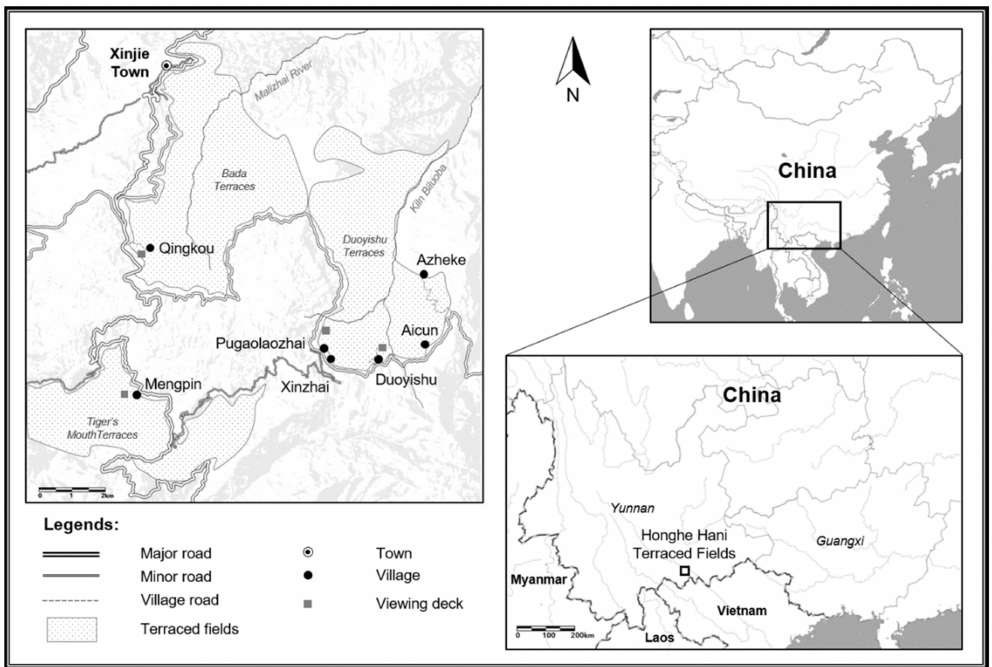
Figure 3. Map of the study